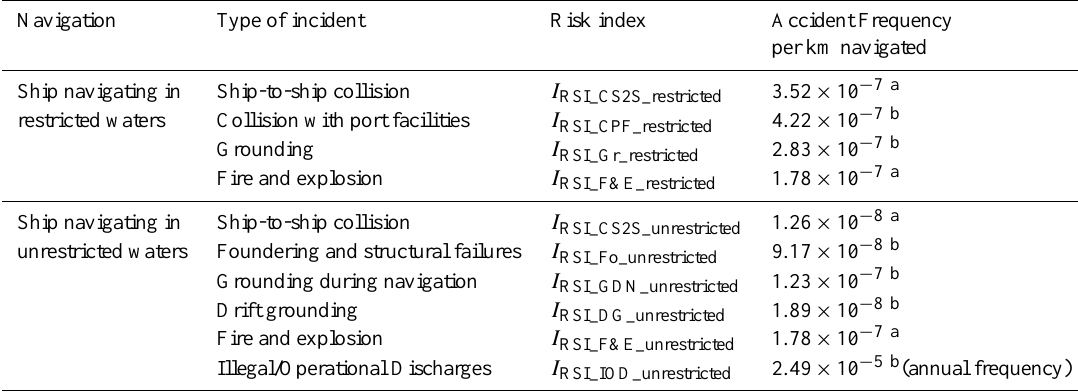
Table B1. Different types of risk of spill incidents, and corresponding spill incident frequency constants.